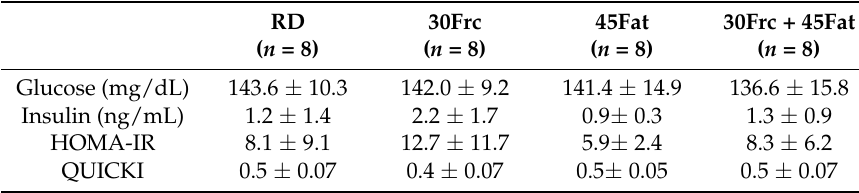
Table 3. Serum levels of glucose and insulin.